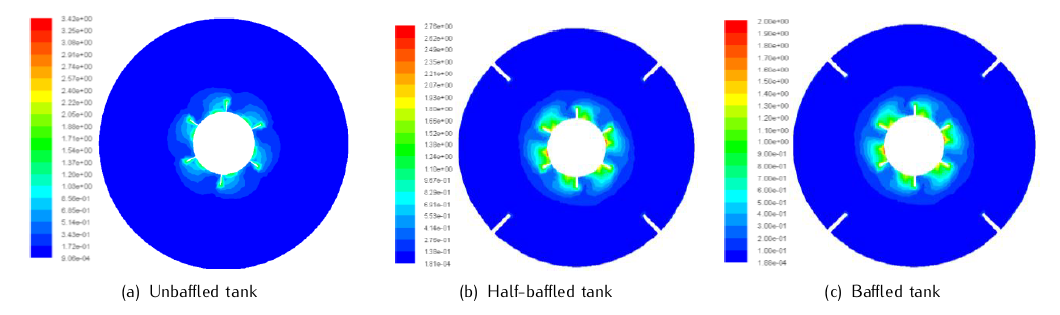
Figure 10. Distribution of the dissipation rate of the turbulent kinetic energy in the r- θ plane.